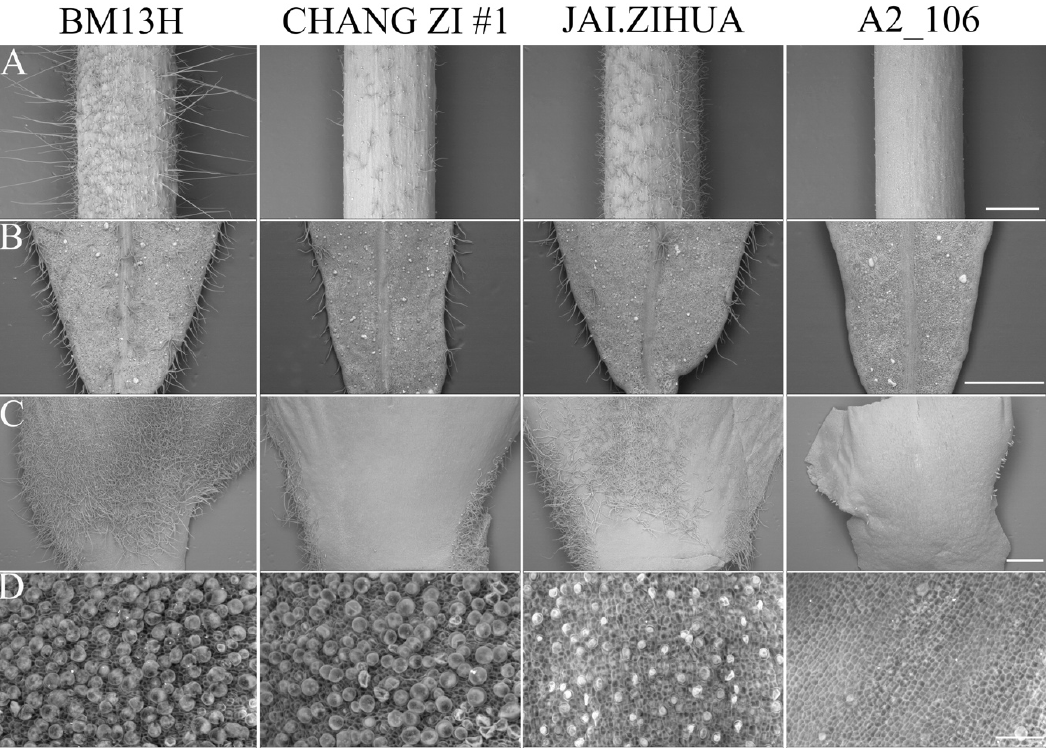
Figure 2. Comparison of trichome phenotype of different tissues from fuzzless (CHANG ZI #1 and JAI.ZIHUA), lintless (A2_106), and normal fibre (BM13H) G. arboreum accessions. ( A ) Trichome phenotype of young petioles (scale bar = 1 mm), ( B ) trichome phenotype of young leaves (scale bar = 1 mm), ( C ) trichome phenotype of petals near the base (scale bar = 1 mm), and ( D ) fibre initials on 0 dpa ovules (Scale bar = 0.05